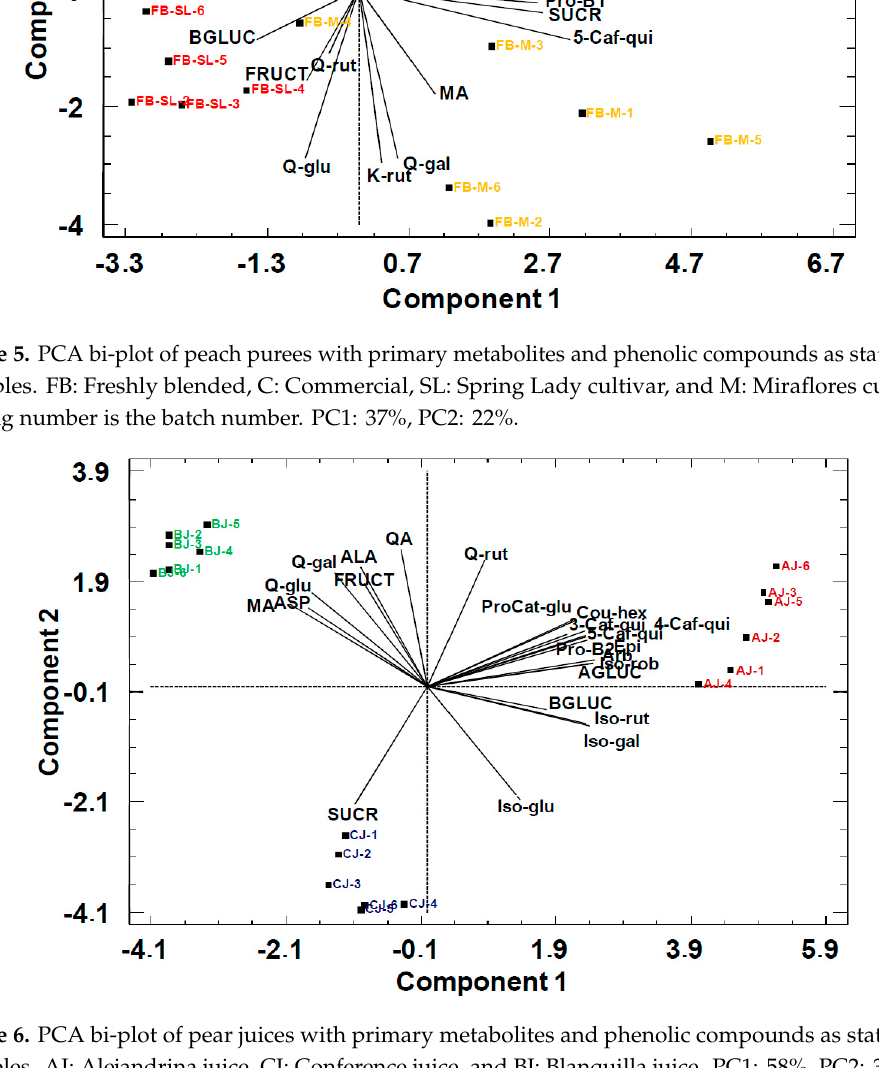
Figure 6. PCA bi-plot of pear juices with primary metabolites and phenolic compounds as statistical variables. AJ: Alejandrina juice, CJ: Conference juice, and BJ: Blanquilla juice. PC1: 58%, PC2: 32%.